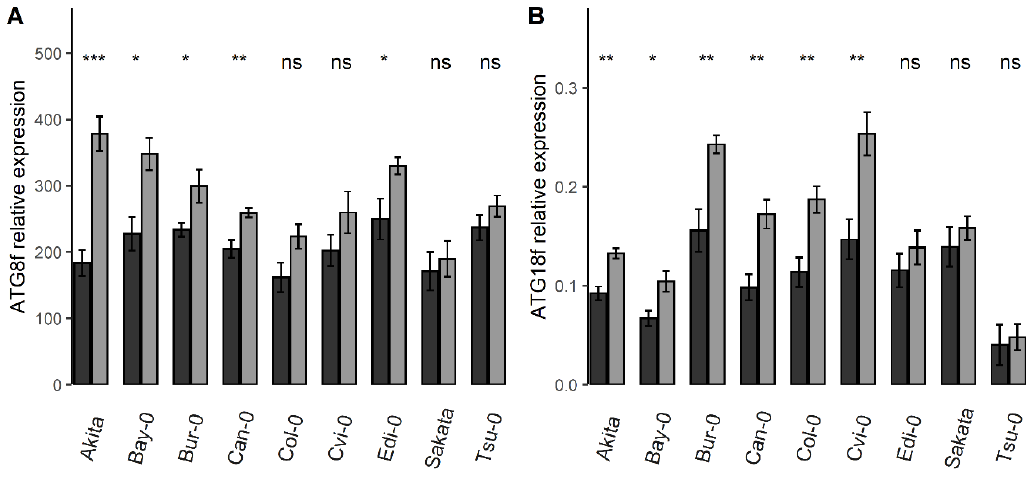
Figure 5. Genetic by Nutrition (G × N) interaction e ff ect on the ATG transcript levels. Bars are the relative expressions of ATG8f ( A ) and ATG18f ( B ) in nine Arabidopsis accessions grown in the control and N starvation conditions (means ± SE). Significant di ff erences between groups are indicated by asterisks (* p < 0.05, ** p < 0.01, *** p < 0.01, n = 8). Dark and light greys show the plant in the control and N starvation conditions, respectively.